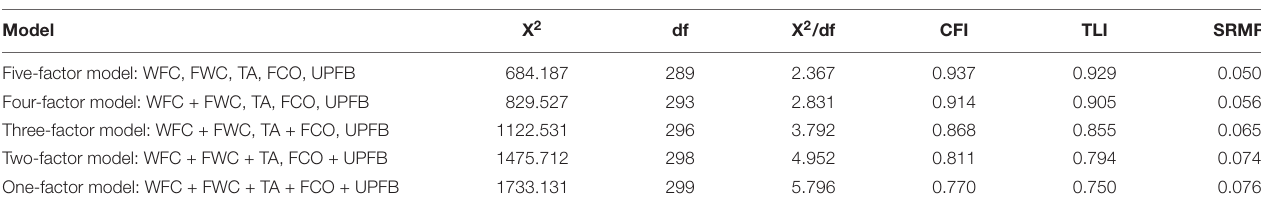
TABLE 1 | Results of confirmatory factor analyses.